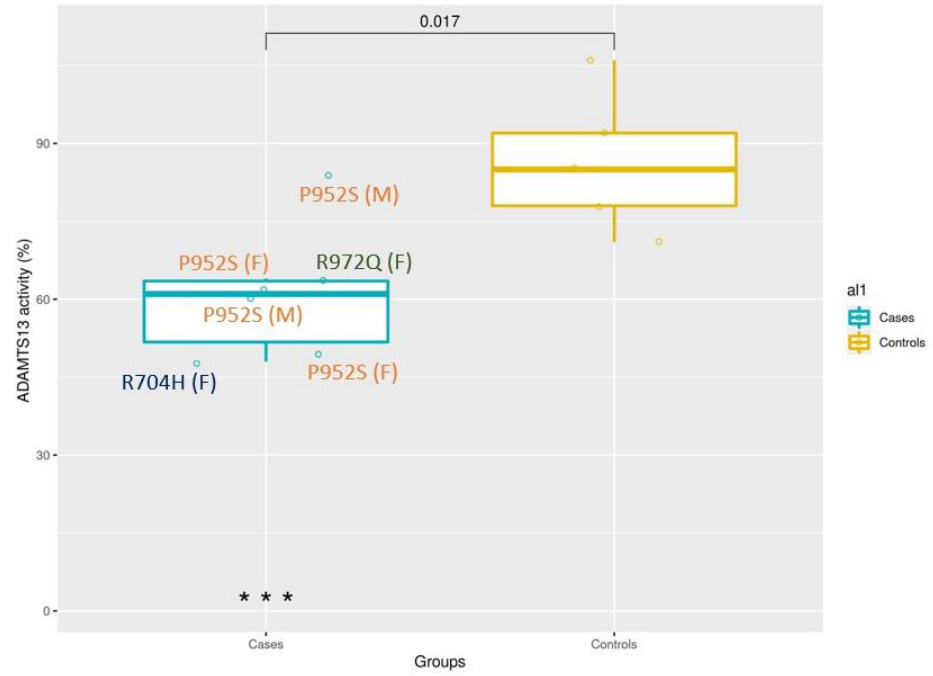
Figure 1. Heterozygous ADAMTS13 ultra-rare variants are related to a reduction of protein detection. Box plot of patients with one ultra-rare variant (6 cases) and patients without ultra-rare variants (5 controls). The presence of ultra-rare variants is associated with a reduction of ADAMTS13 activity ( p -value = 0.017 at Mann–Whitney U test).